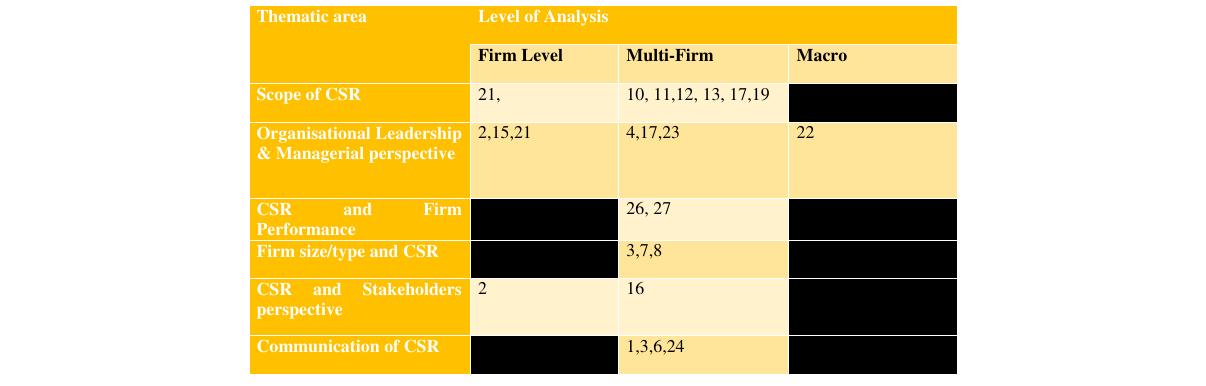
Table 2 Level of Analysis Thematic area Level of